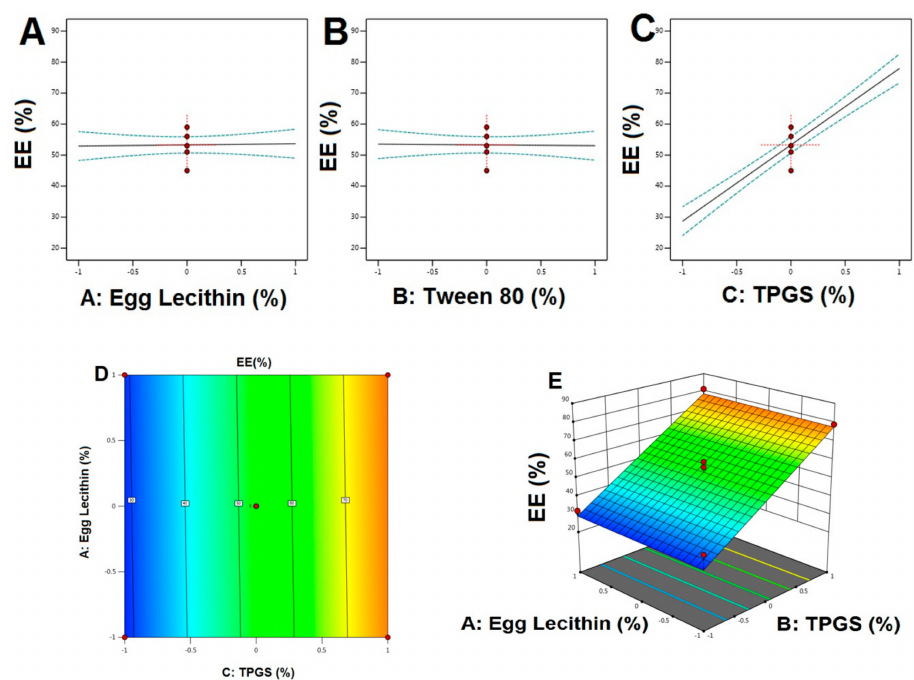
Figure 2. Main e ff ect diagram, contour, and 3-D response surface plots representing the e ff ect of studied variables on the EE (Y2). ( A ). Main e ff ect diagram of Egg Lecithin (%) on EE%; ( B ). Main e ff ect diagram of Tween 80 (%) on EE%; ( C ). Main e ff ect diagram of TPGS (%) on EE%; ( D ). Contour Plot showing the e ff ect of Egg lecithin and TPGS on EE; ( E ). 3-D Surface plot representing the e ff ects of the egg lecithin (%) and TPGS (%) on EE.